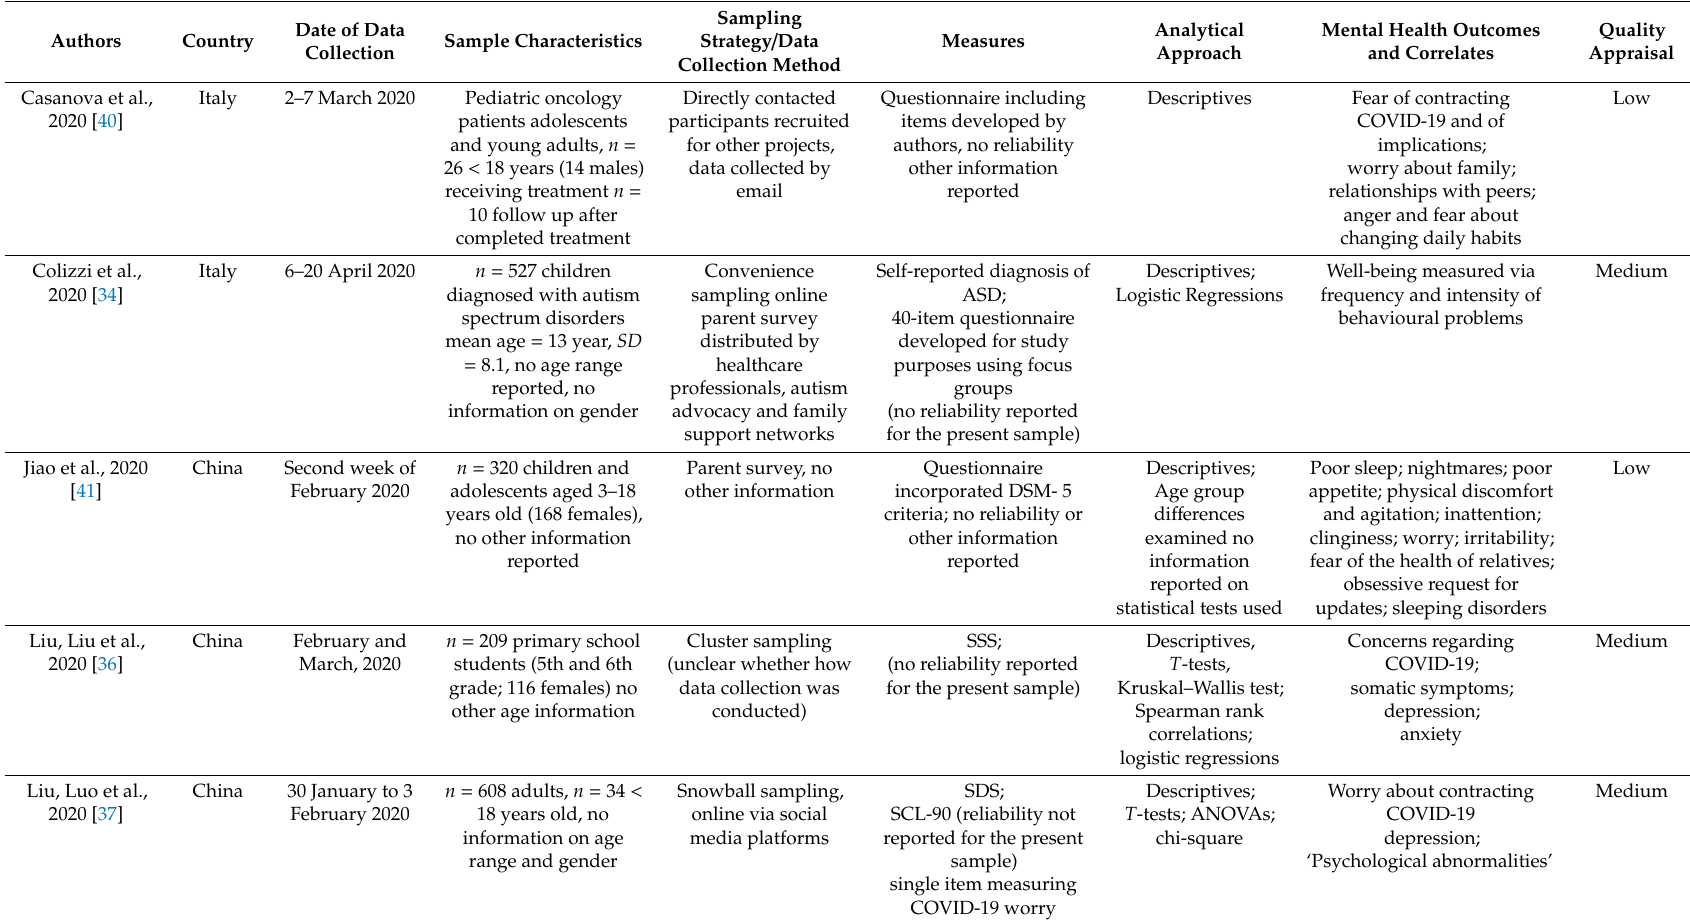
Table 2. Methodological features and quality appraisal of included